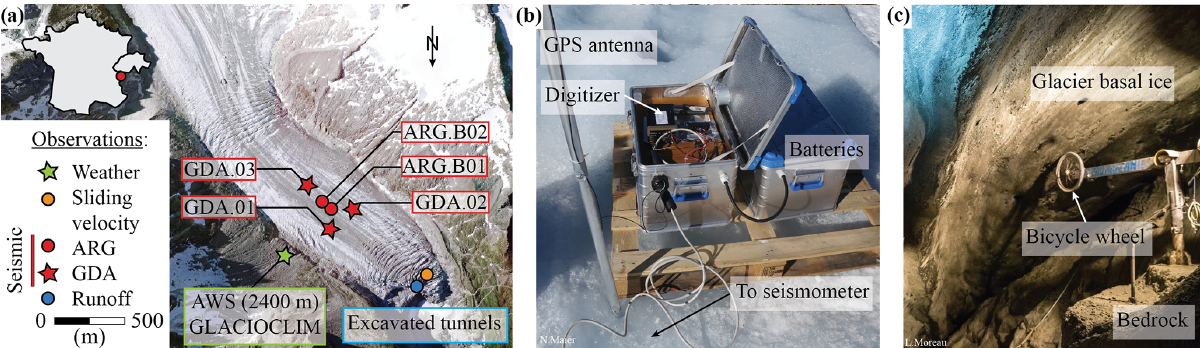
Figure 2. Monitoring set-up of Glacier d’Argentière. (a) Aerial view of Glacier d’Argentière field site (France) and location of the instruments used in this study. The aerial photography was taken in 2015. The seismic network is composed of the GDA (red circles) and ARG (red stars) borehole stations and is located according to positions in summer 2018. Station ARG.B02 is installed ca. 70m deep in the ice, whereas the four other stations are installed ca. 5m deep. The GLACIOCLIM (https://glacioclim.osug.fr/, last access: 28 April 2020) automatic weather station (AWS; green star) provides air temperature and precipitation. Basal sliding speed (orange circle) and water discharge (blue circle) are measured thanks to direct access to the glacier base from excavated tunnels. Basal water pressure is measured at a similar location to that of basal sliding speed measurements. (b) Picture of the seismic instrumental set-up used in this study. (c) Picture of the subglacial observatory with the bicycle wheel used to measure basal sliding speed. Photo credits: (a) IGN France, https://www.geoportail.gouv.fr/ (last access: 28 April 2020), (b) Nathan Maier and (c) Luc